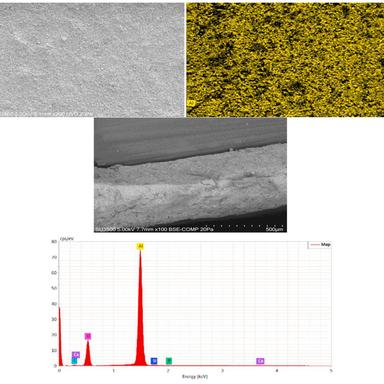
Morpho-chemical analysis of the surface of C/C material coated by Al-oxide based varnish enriched by 1 wt% of Si-oxide nanosphere inclusion. Top, from left to right: low SEM magnification, EDX elemental map. Center: high SEM magnification of the sample edge. Bottom: elemental analysis.